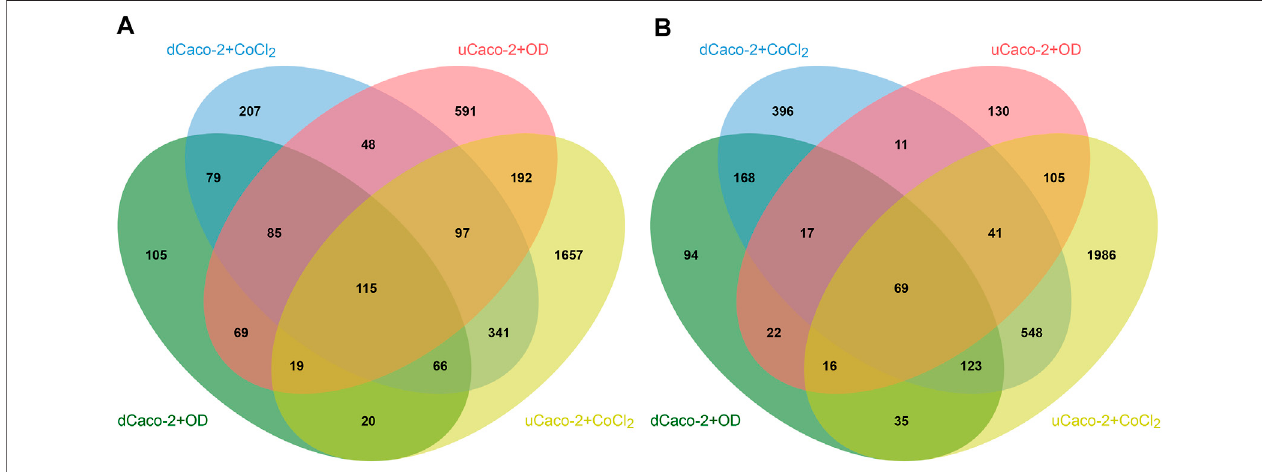
FIGURE 2 | Intersections of differentially expressed genes in differentiated Caco-2 (dCaco-2) and undifferentiated Caco-2 (uCaco-2) upon cobalt (II) chloride (CoCl 2 ) and oxyquinoline derivative (OD) treatment. (A) — upregulated genes. (B) — downregulated